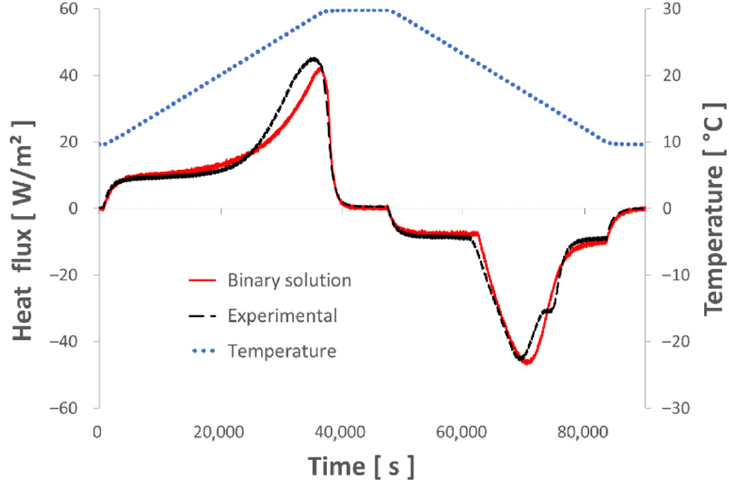
Figure 7. Evolution of the heat flux exchanged between the plate and the sample: binary solution and experimental.